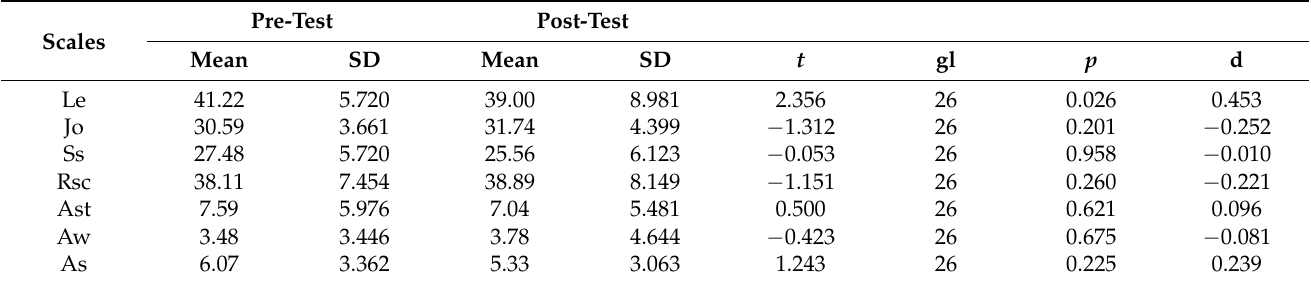
Table 4. Scores obtained in the parents’ BAS at the beginning and end of the first grade of pri- mary school.